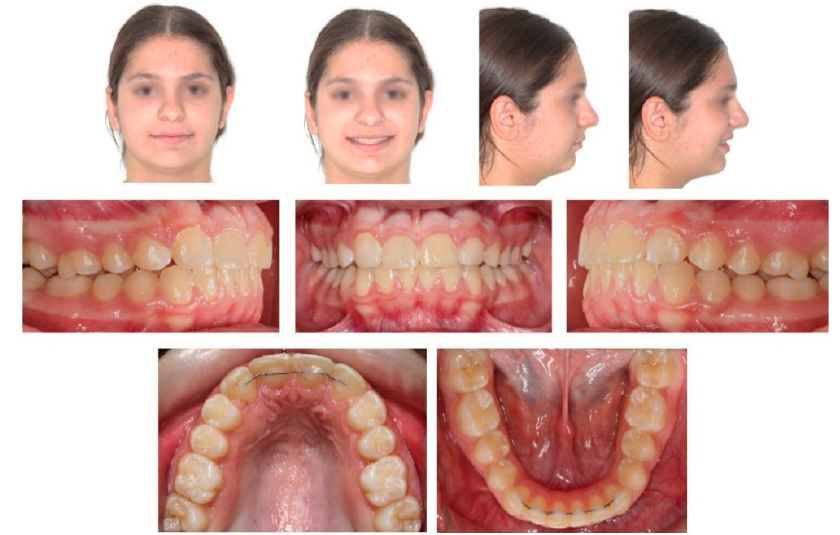
Figure 9. Post-treatment extra- and intra-oral photographs.